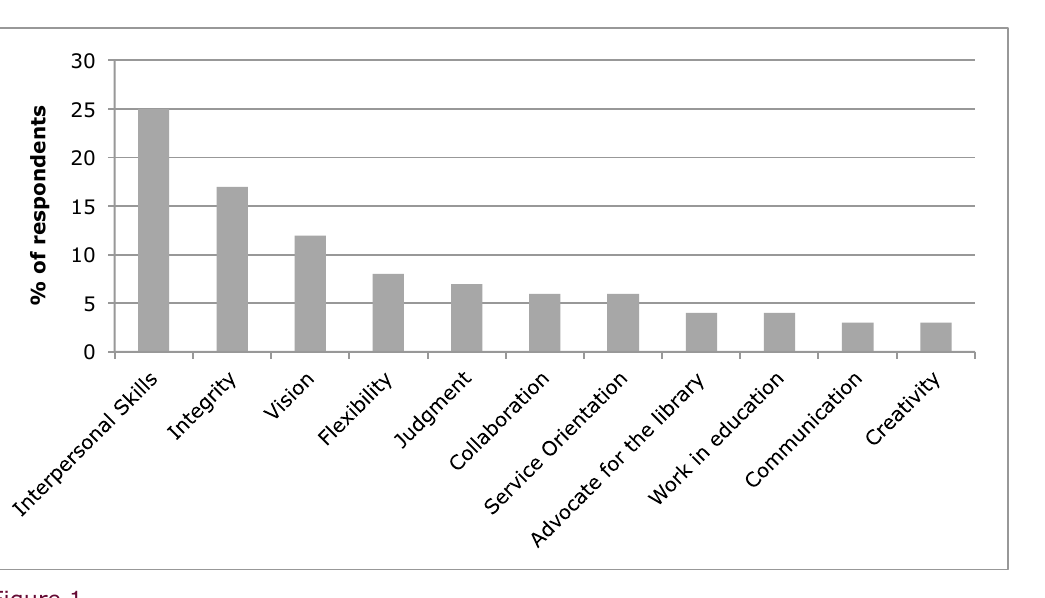
Most Important Manager